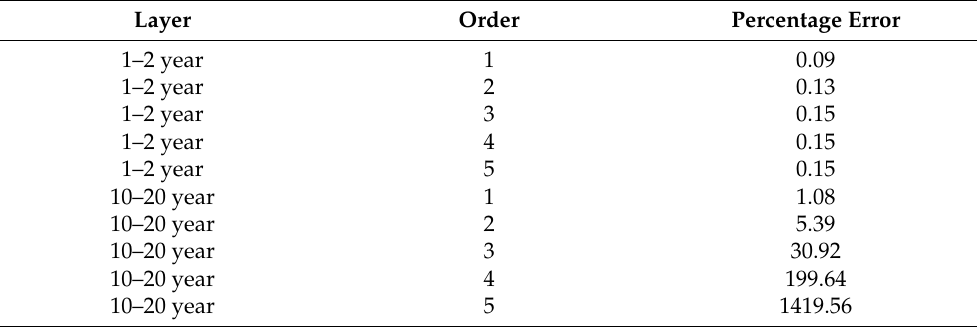
Table 6. Convergence errors for various AAL results displayed in Figure 8 are provided for the S = 100 K simulation years case. Column 1 provides the layer definition, Column 2 provides the occurrence loss order and Column 3 the percentage error. Results are analogous to the pre-catXL convergence errors displayed in Table 2.